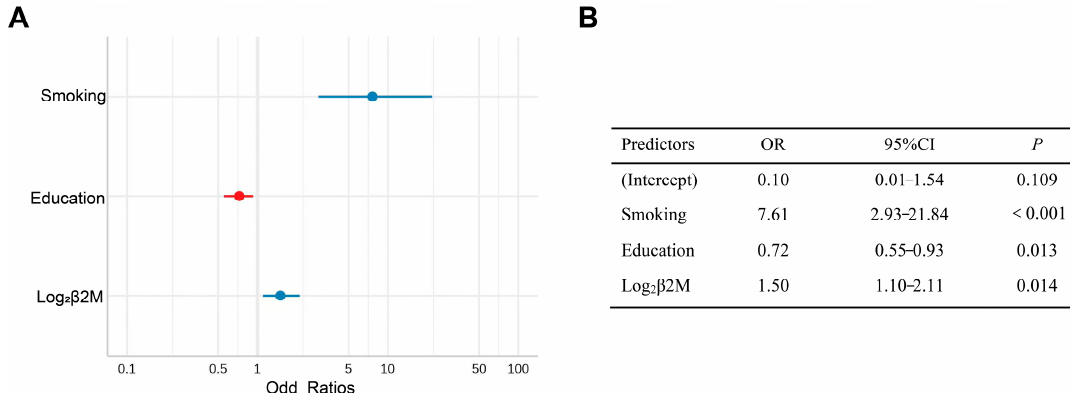
Figure 2. Spearman correlation analysis of KIM-1 ( A ), NGAL ( B ), MCP-1 ( C ), β 2M ( D ), and MoCA scores.